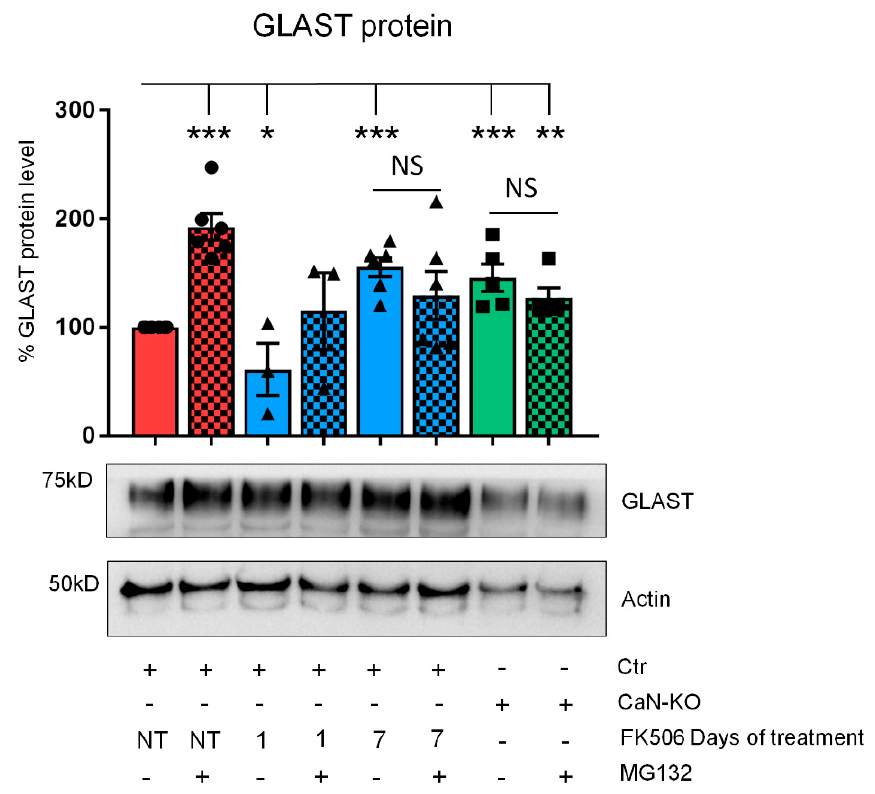
Figure 4. Long-term, but not short-term CaN inhibition suppresses GLAST protein degradation. GLAST protein expression in primary cultures of hippocampal astrocytes from Ctr, Ctr treated with FK506 (200 nM) for 1 and 7 days and from astrocytes-specific CaN-KO mice. Where indicated, MG132 was added 3 h before lysis. Data are expressed as mean ± SD, 6 independent cultures were used for both Ctr and Ctr treated with FK506 for 7 days, 5 for CaN-KO, and 3 for Ctr treated with FK506 for 1 day. * p < 0.01; ** p < 0.01; *** p < 0.001, unpaired two-tailed Student’s t-test.